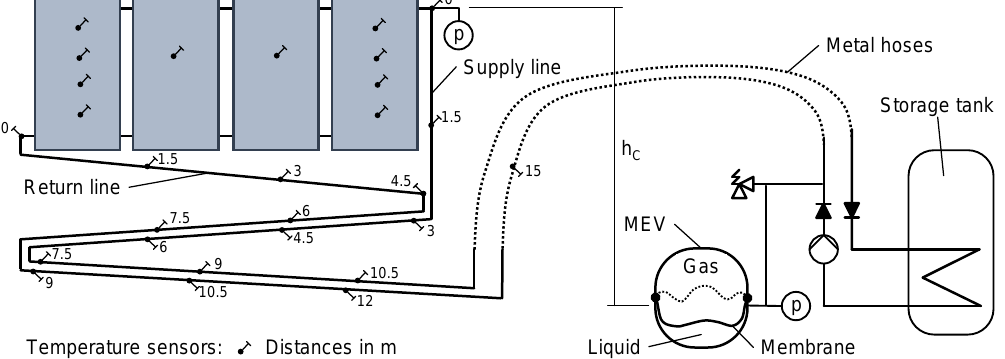
Figure 2. Hydraulic diagram of the circuit, components and temperature sensor positions, valid for both systems. Well-defined stagnation experiments were performed in parallel, i.e., under the same boundary conditions, to quantify the effect of different absorber coatings on the steam range and to provide a data set for validation. Ambient air temperature as well as wind speed and the solar irradiation in the collector plane were measured at a location between